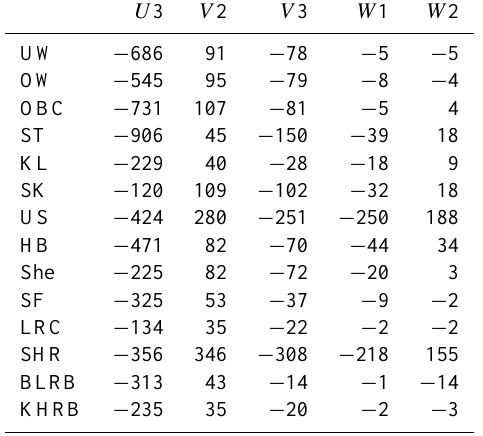
Units are 10 3 m 3 s − 1 . U , V , W represent zonal, meridional and vertical transport values, respectively (Fig. 3). Negative values indicate downstream, offshore, and downwards transport, respectively.